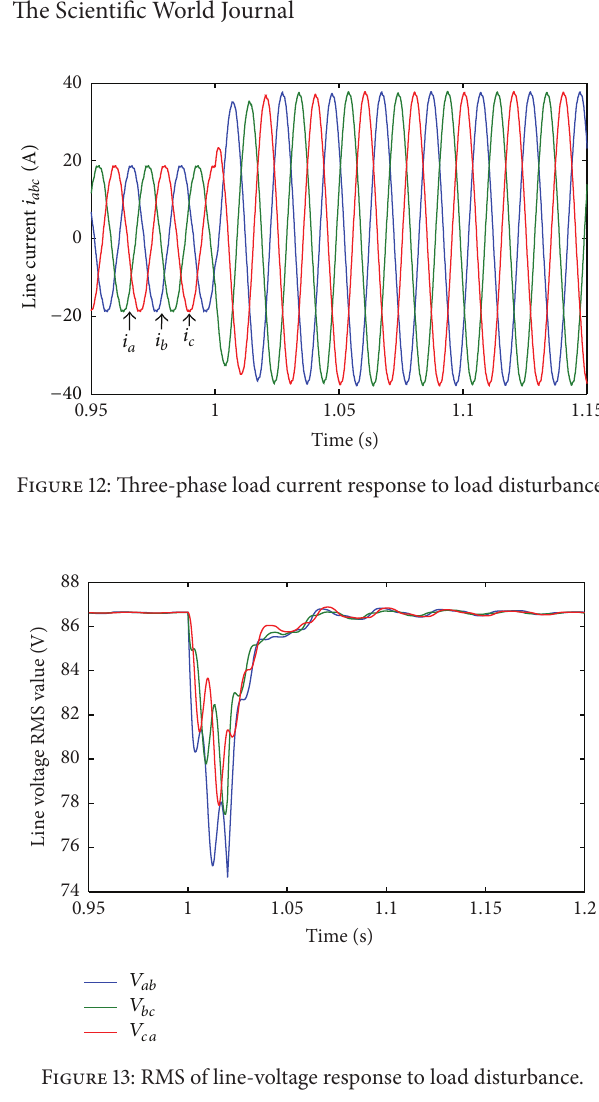
shows the corresponding line-current response. The THD of load current before and after the disturbance is 2.21% and 0.81%. Figure 13 shows the corresponding RMS of line- voltage response. Figure 14 shows the corresponding optimal switching angles response. The transient recovery time is about 0.2 s.